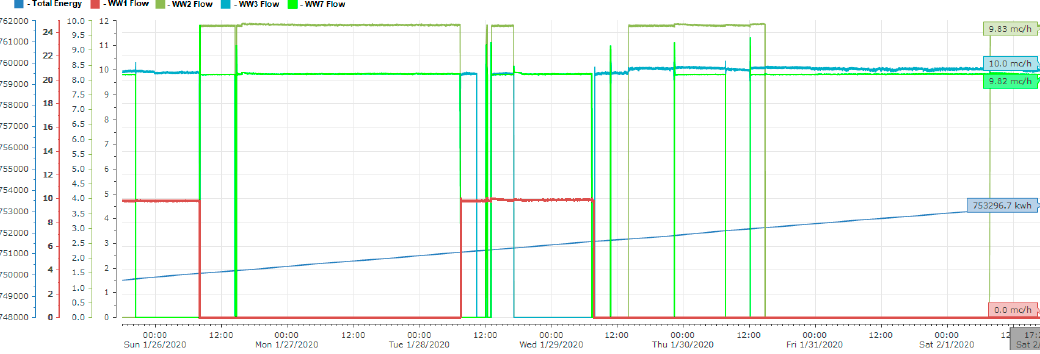
Figure 15. Results without FDC. Well flows (mc/h) and energy consumption (kWh) in Week 3 of tests.